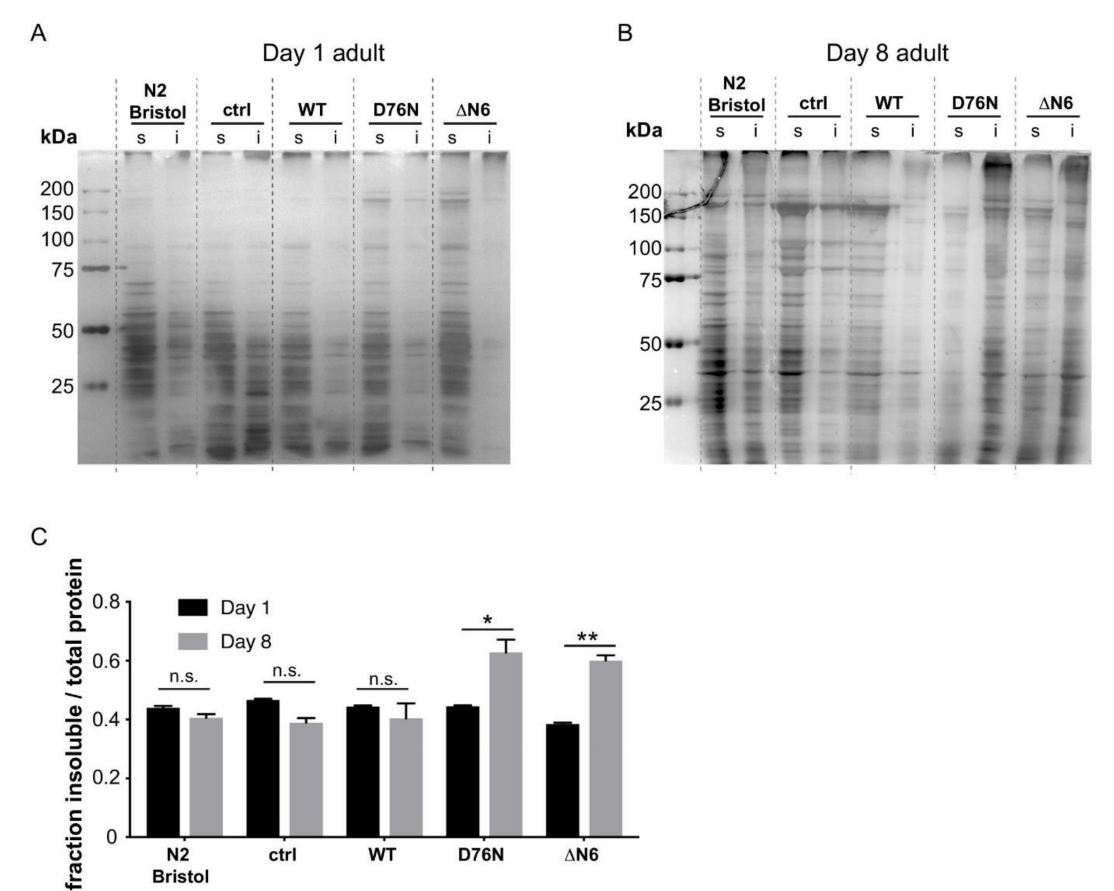
Figure 3. Soluble and insoluble fractions of total protein lysates of Day 1 and Day 8 adult nematodes. Representative silver-stained SDS PAGE of soluble (s) and insoluble (i) fractions of total protein lysates of ( A ) day-1 and ( B ) day-8 adult animals expressing the indicated β 2 m variant. ( C ) Densitometry analysis of the ratio of insoluble protein relative to the total protein (sum of soluble and insoluble) present in Day 1 and Day 8 animals, as shown in SDS PAGE in ( A ) and ( B ). Density of lanes were analysed using ImageJ, and the fraction of insoluble protein was calculated using [density of insoluble proteins]/[density of soluble + density of insoluble proteins]. Western blot images of three independent experiments were analyzed and Student’t t test was used to calculate statistical significance between Day 1 and Day 8. * p < 0.05; ** p <0.01; n.s. not